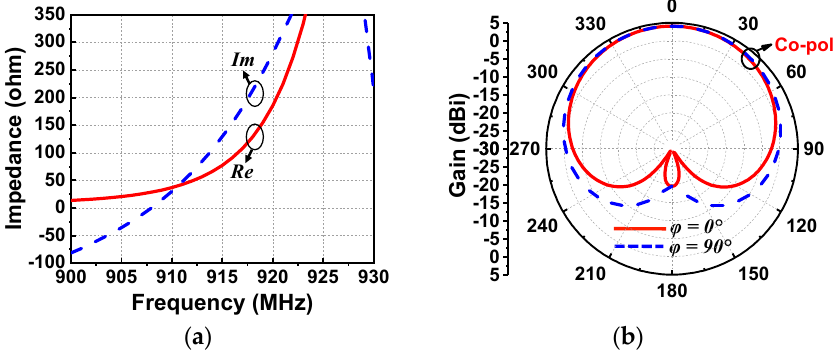
Figure 9. Simulated performance characteristics of the Huygens receiving antenna: ( a ) input impedance